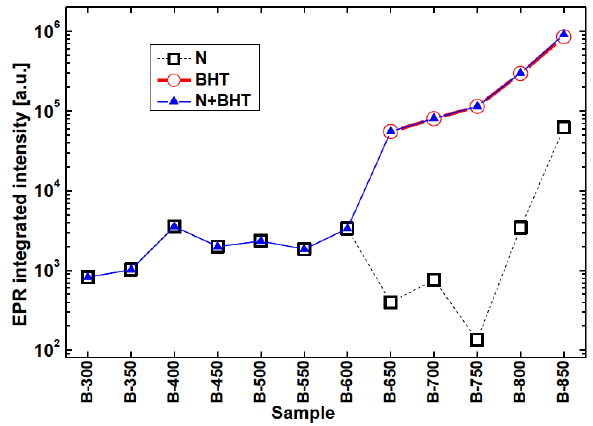
Figure 15: EPR integrated intensity of N and BHT components in different samples at RT calculated for sample mass unit.